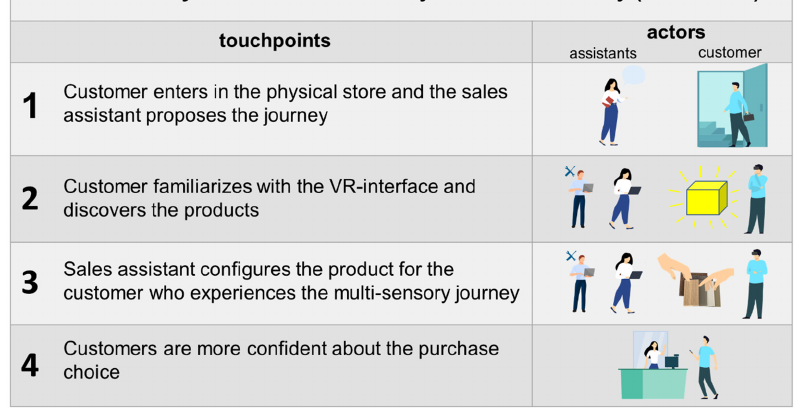
Figure 3. The Multi-Sensory In-Store Virtual Reality Customer Journey touchpoints and the actors involved.